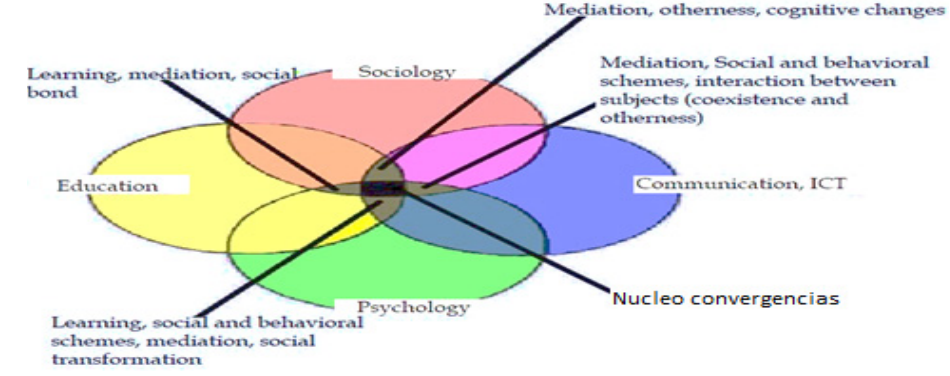
Figure 10. Venn Diagram—Convergences. Source: Self-generated.